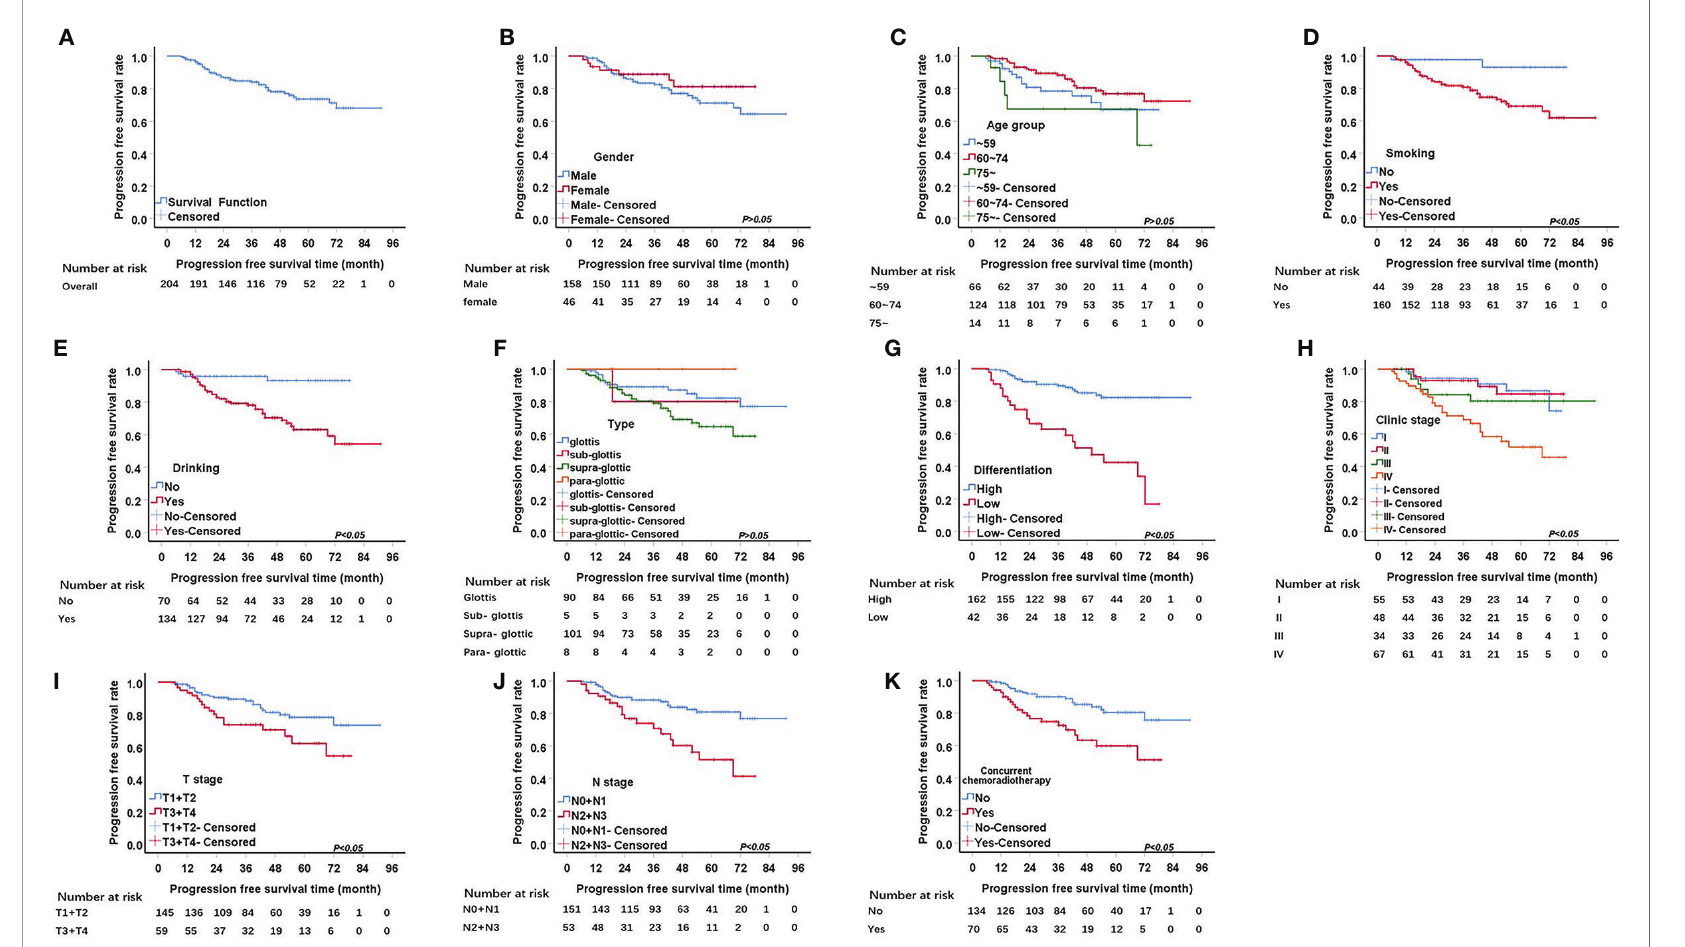
FIGURE 2 | Kaplan-Meier curves of progression free survival (PFS) probability against time. (A) Kaplan-Meier curves for PFS. (B) There was no signi fi cant differences between male and female, p>0.05. (C) There was no signi fi cant differences among age group, p>0.05. (D) The PFS rate for tabacoo users was signi fi cantly lower than non-smokers, p=0.008. (E) The PFS rate for those who used to drink was signi fi cantly lower than those did not, p=0.000. (F) There was no signi fi cant difference among group of type, p>0.05. (G) The PFS rate for those with low pathological differentiation tumors was signi fi cantly lower than those were high, p=0.000. (H) The PFS rate for patients with clinical stage IV was signi fi cantly lower than those with I, II, III, respectively, p=0.000. (I) The PFS rate for those at stage T3 and T4 was signi fi cantly lower than those at T1 and T2, p=0.024. (J) The PFS rate for those at stage N2 and N3 was signi fi cantly lower than those at N1 and N0, p<0.05. (K) The PFS rate for those with concurrent chemoradiotherapy was signi fi cantly lower than those not,